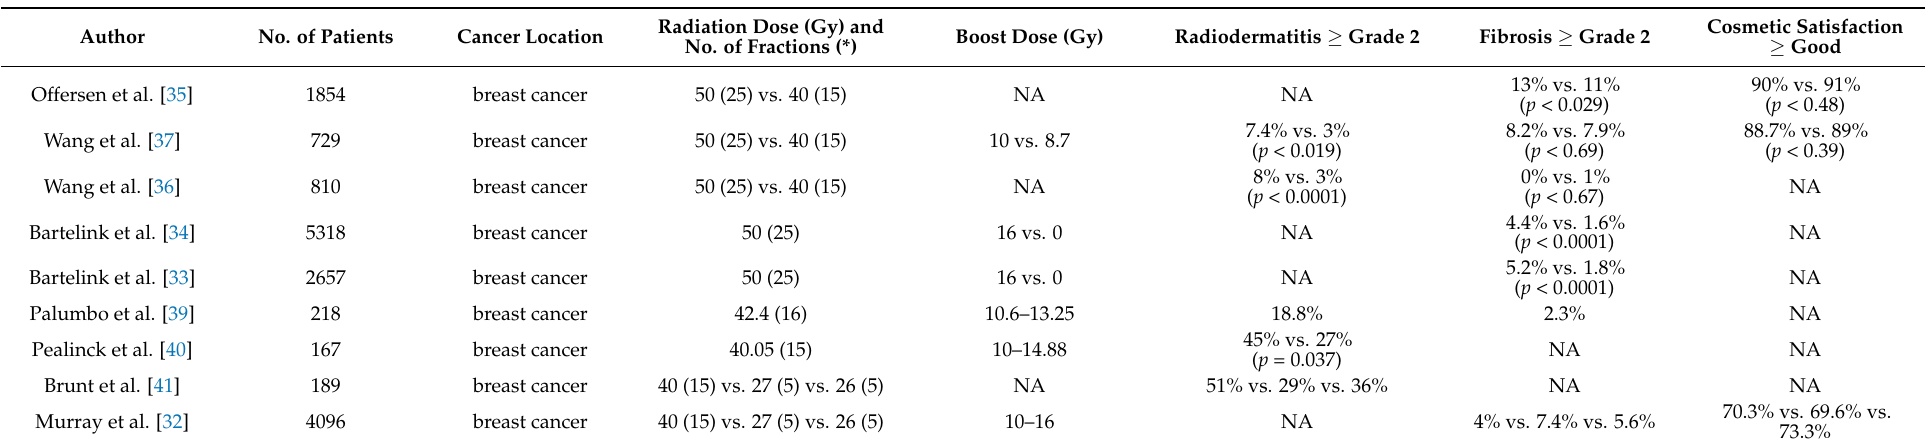
Table 2. Acute and late toxicities depending on the number of